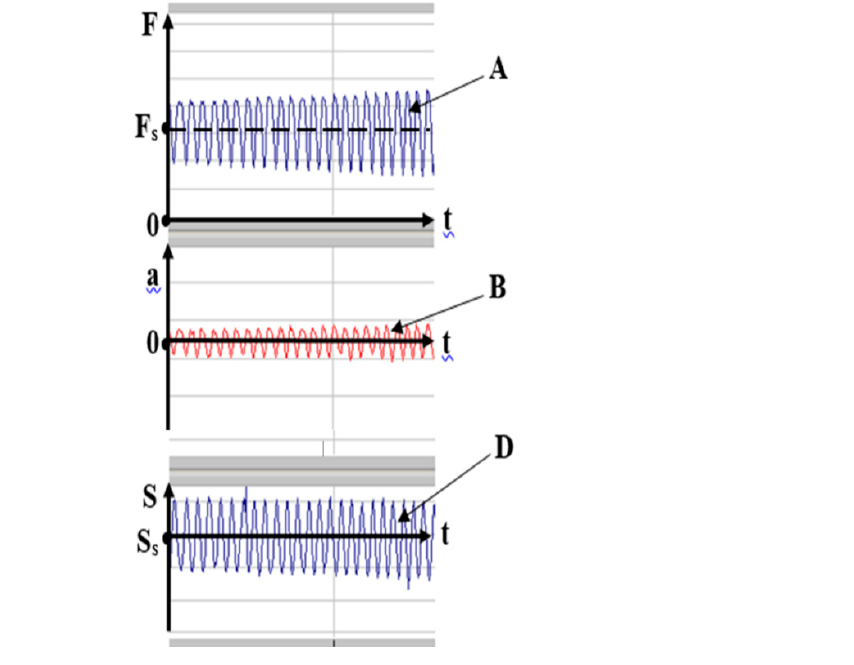
Figure 4. Waveform of the experimental, adaptive suspension of the VW PASSAT CC car.